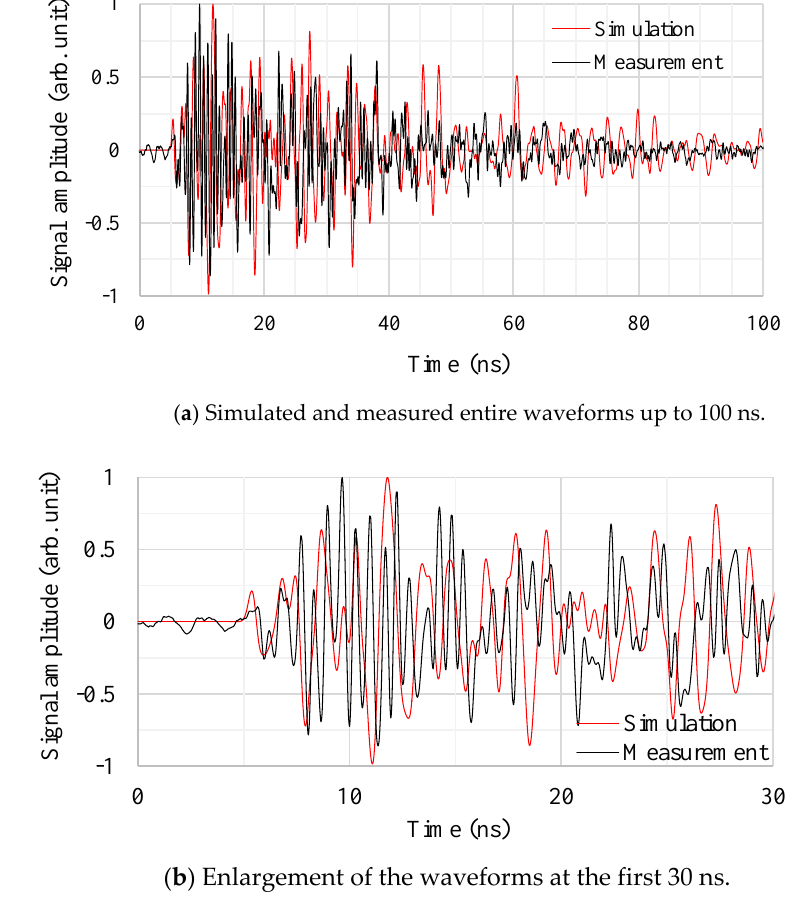
Figure 13. Example of the simulated and measured EM waveforms. (EM wave source position 3, UHF sensor C).